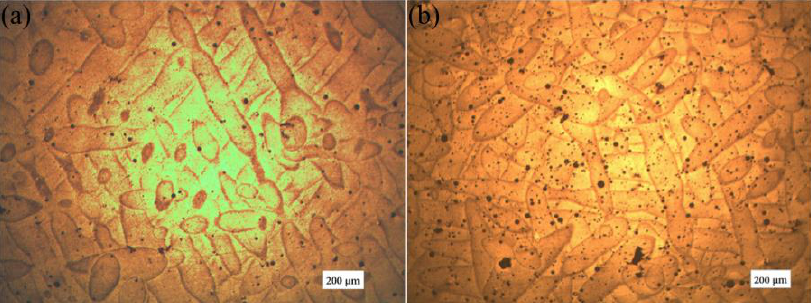
Figure 6. Optical micrographs of ( a ) AlSi10Mg, and ( b ) 0.5wt.% graphene nanoplatelets Optical micrographs of ( a ) AlSi10Mg, and ( b ) 0.5 wt.% graphene nanoplatelets (GNP)/AlSi10Mg parts in as-built condition [88]. (GNP) / AlSi10Mg parts in as-built condition